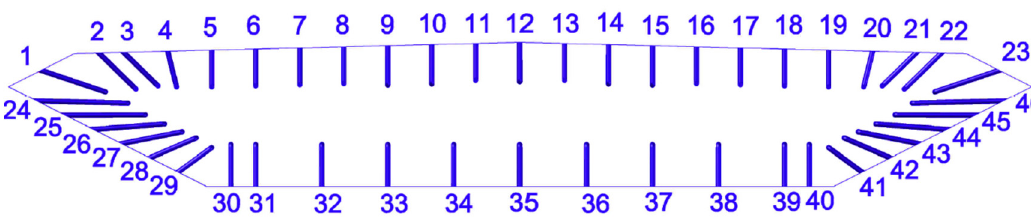
Figure 2. The pressure taps that were distributed around the test